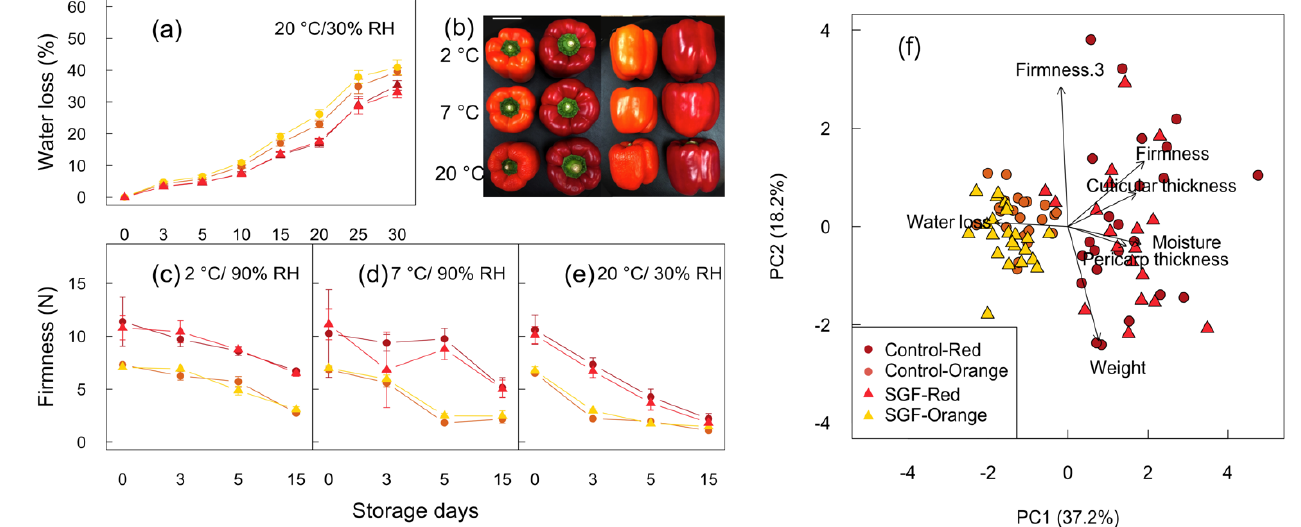
Figure 4. Assessment of shelf life by measuring water loss and firmness in mature ripe Red and Orange fruits from plants grown under SGF. ( a ) Line graph displays percentage water loss in fruits stored at 20 ◦ C and 30% relative humidity (RH). ( b ) Appearance of fruits after 15 days of storage at different storage temperatures. ( c – e ) Line graph displays firmness (Newtons, N) of fruits stored at 2 ◦ C and 90% RH ( c ), 7 ◦ C and 90% RH ( d ), and 20 ◦ C and 30% RH ( e ) after 0, 3, 5, and 15 days of storage. Scale bar = 5 cm. ( f ) Principal component analysis (PCA) showing multivariate associations among Firmness.3 (Firmness loss in day 3 stored 20 ◦ C/30%RH), percentage water loss (day 3), cuticle and pericarp thickness parameters in both cultivars grown under SGF relative to the control. Standard error bars are displayed ( n = 6–12). A one-way ANOVA did not reveal any significant differences ( a , c – e